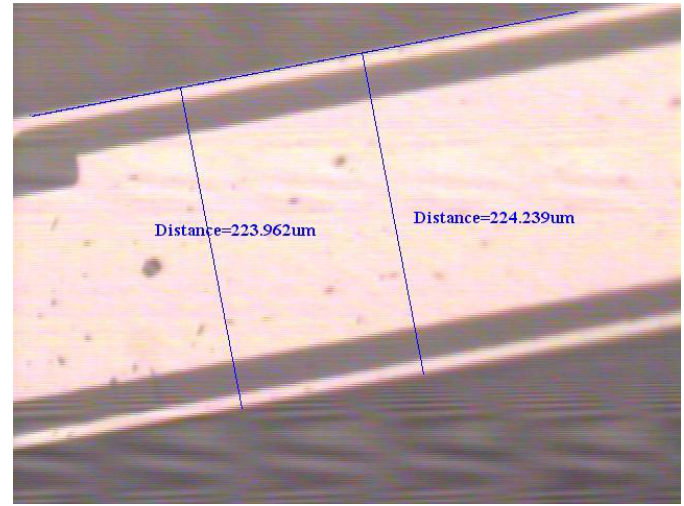
Figure 13. Determination of the width of the prong from a microscope image.